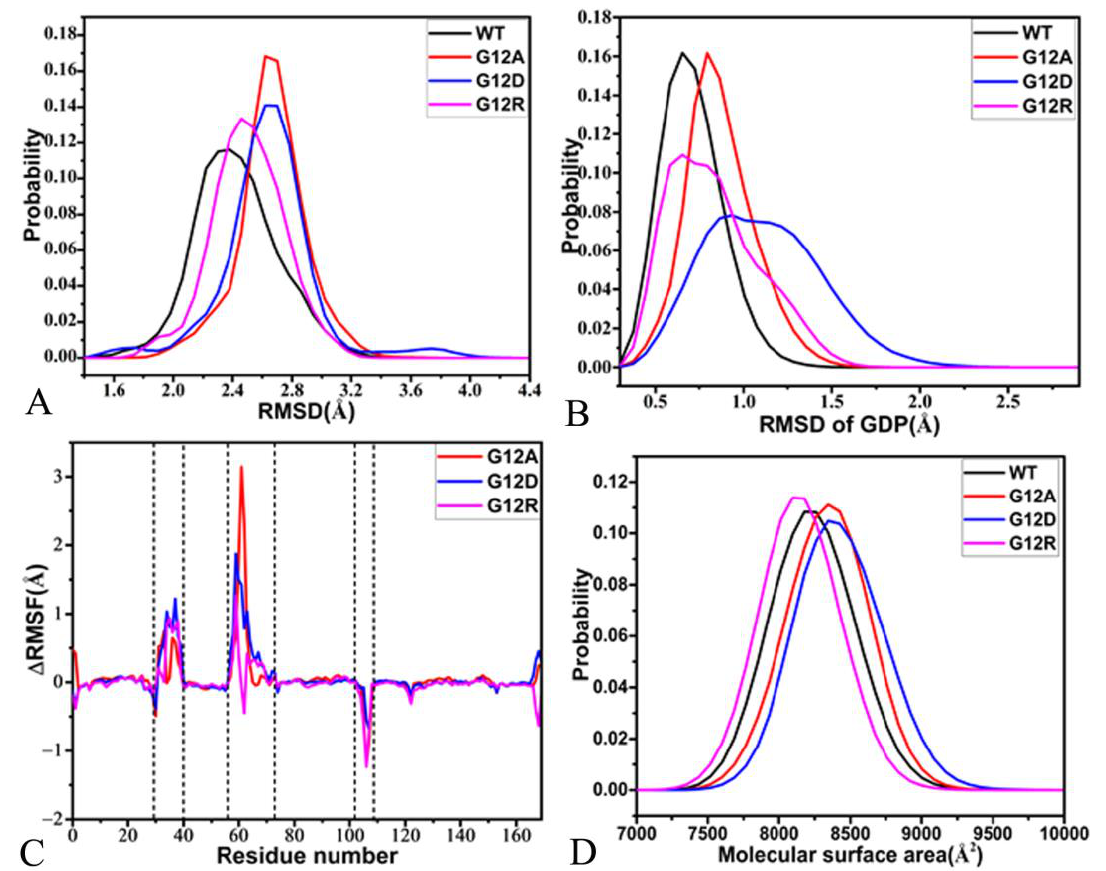
Figure 2. Structural fluctuations and flexibility: ( A ) probability of RMSDs for non-hydrogen atoms of KRAS, ( B ) probability of RMSDs for non-hydrogen atoms of GDP, ( C ) difference in RMSFs of the Cα atoms from KRAS, and ( D ) molecular surface areas of KRAS.